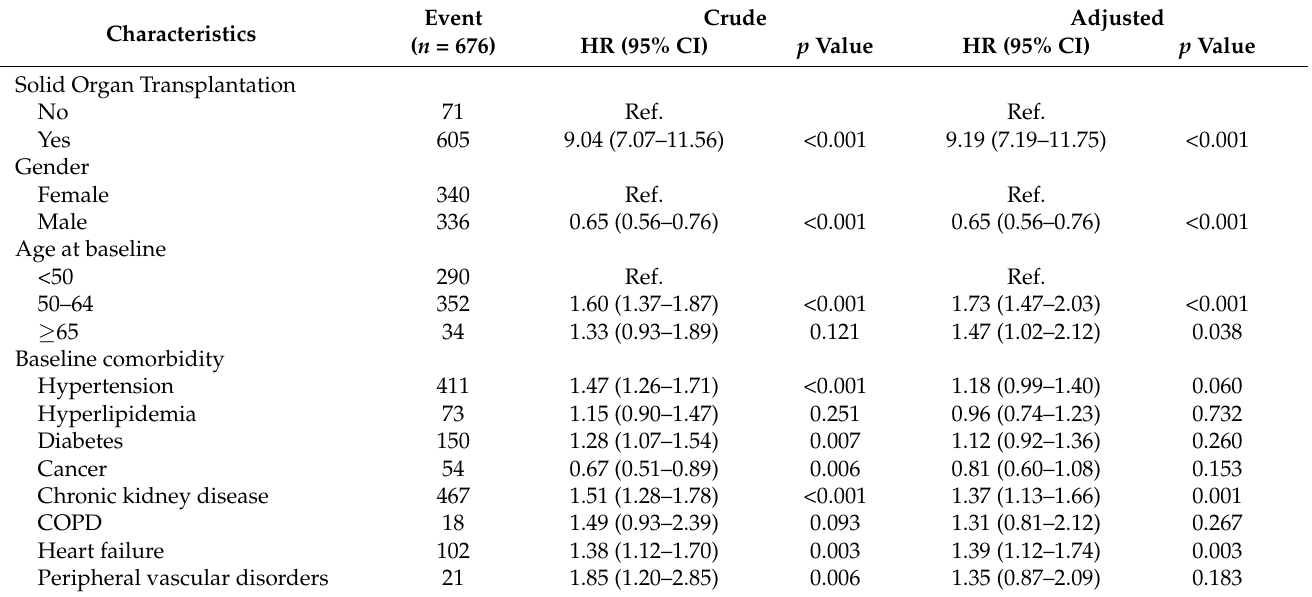
Table 2. Patients’ risk of herpes virus infection with and without solid organ